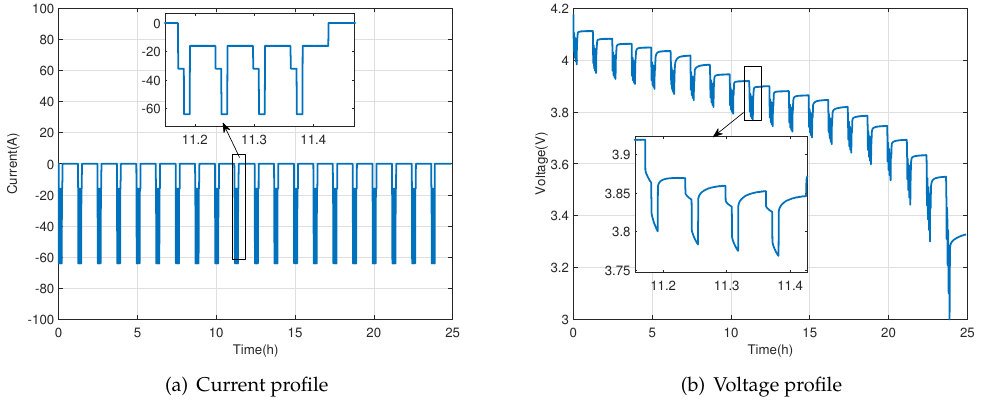
Figure 3. Voltage and current profiles for parameter estimation.